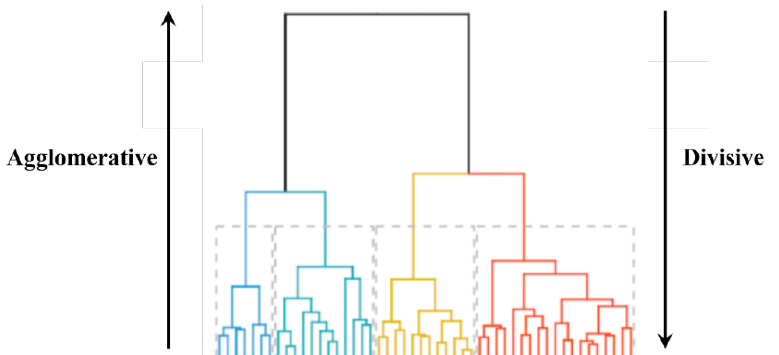
Figure 3. Agglomerative and divisional strategies of hierarchical clustering.